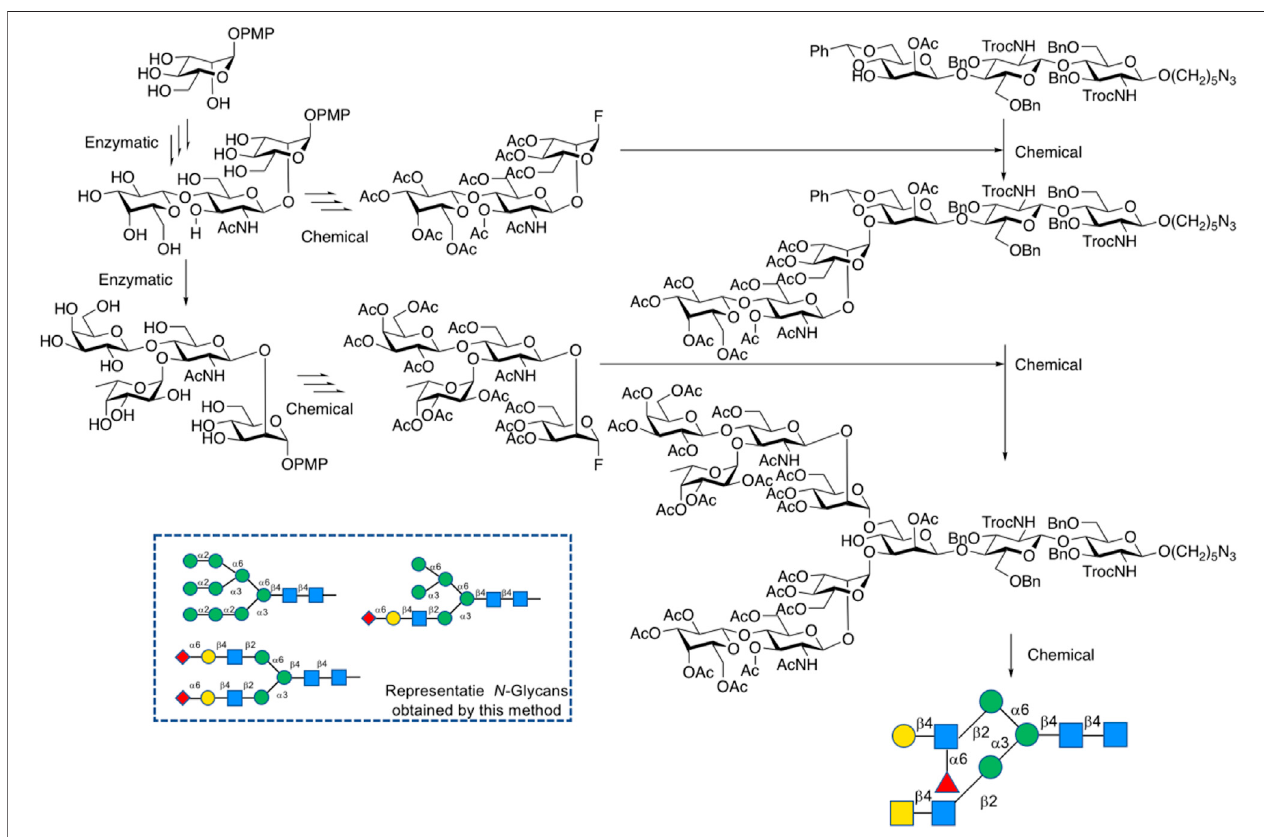
FIGURE 10 | Chemo-enzymatic synthesis of modules.